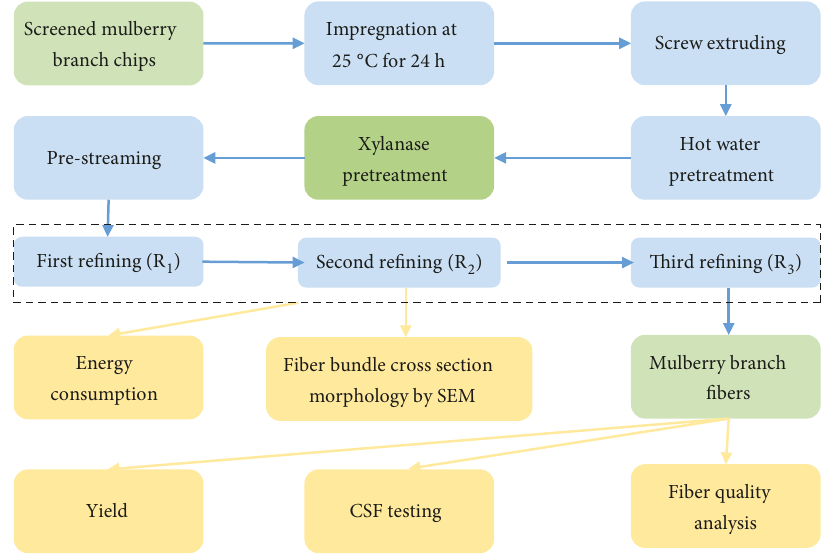
Figure 1: Experimental